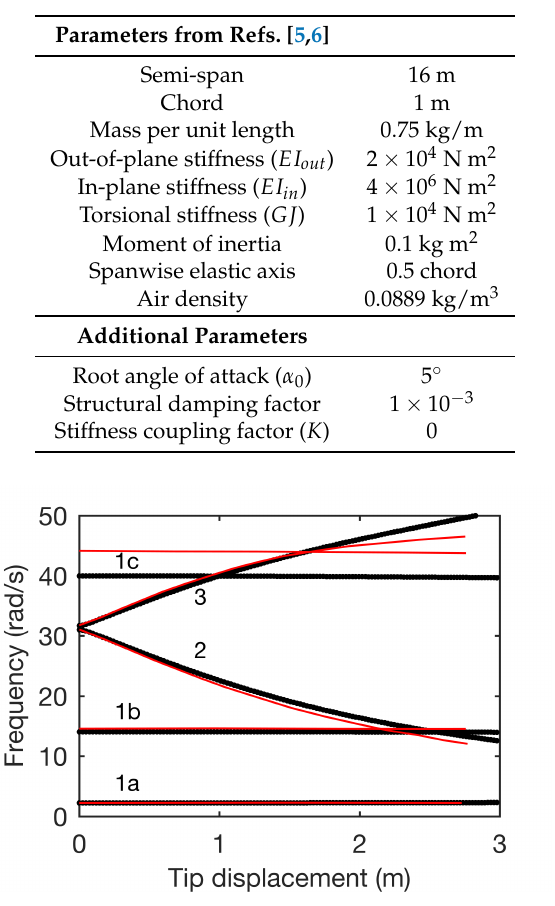
Table 1. Nominal wing parameters.